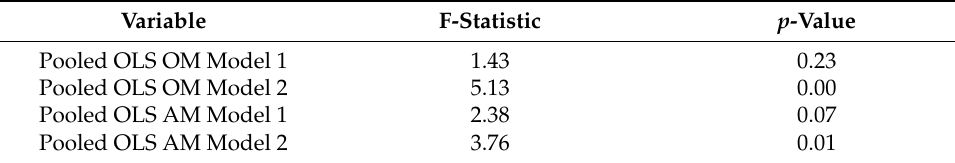
Table A6. Ramsey REST test for omitted variables in panel data.